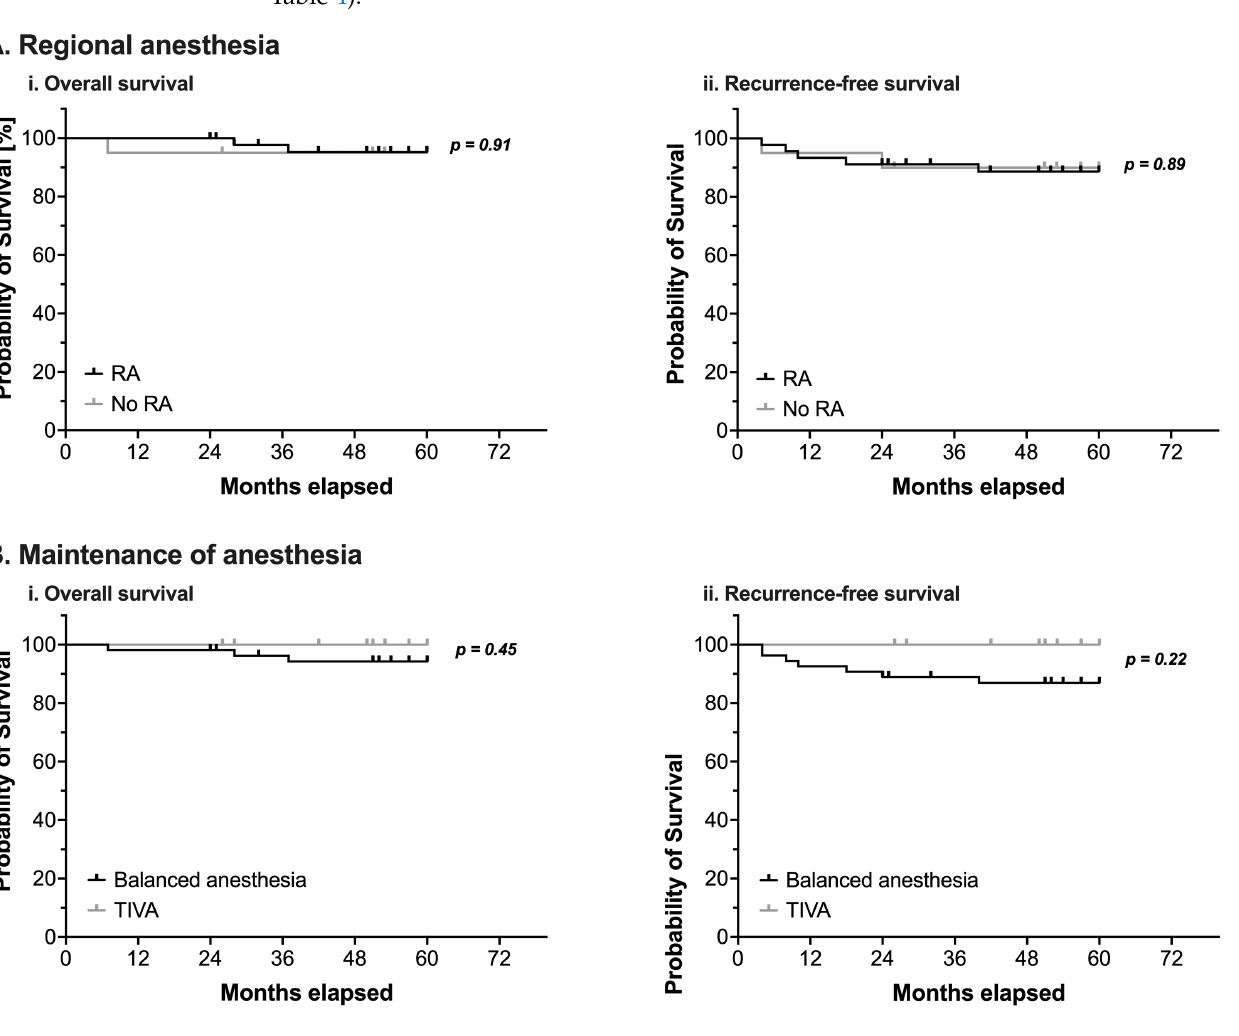
Figure 2. ( A ) Kaplan-Meier estimates of overall survival ( i ) and recurrence-free survival ( ii ) in pediatric patients undergoing surgery for nephroblastoma ( n = 65). Survival analysis using a log-rank test compared patients with (black line) or without (grey line) intraoperative use of regional anesthesia (RA). ( B ) Kaplan-Meier estimates of overall survival ( i ) and recurrence-free survival ( ii ) in pediatric patients undergoing surgery for nephroblastoma ( n = 65). Survival analysis using a log-rank test compared patients in whom anesthesia was either maintained with volatile anesthetics (balanced anesthesia, black line) or with total intravenous anesthesia using propofol (TIVA, grey line). Censored events are marked with upright ticks. p -values as annotated.